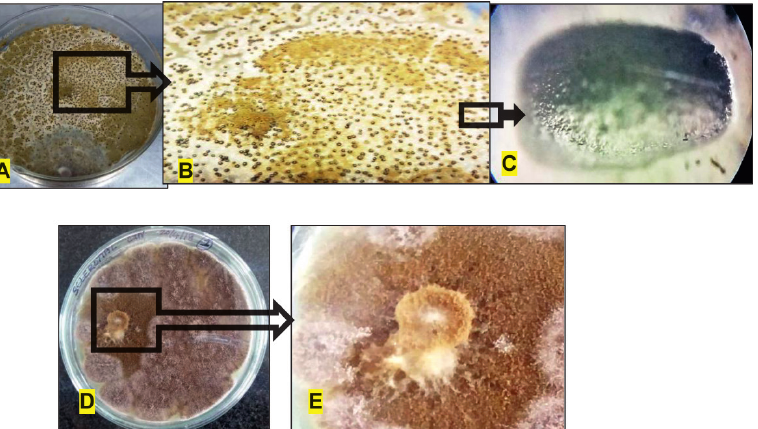
Fig. 14. Impact of A. giganteus on sclerotia production of A. flavus : A- Control petriplate showing growth of A. flavus with abundant sclerotia, B- Closer view of sclerotia in control plate, C- Zoomed picture of a single prolate spheroid sclerotia as viewed in a light microscope under 100Xmagnification, D- Coculture petriplate showing the reduced growth of A. flavus , E- Closer view of coculture plate showing no visible sclerotia formation.